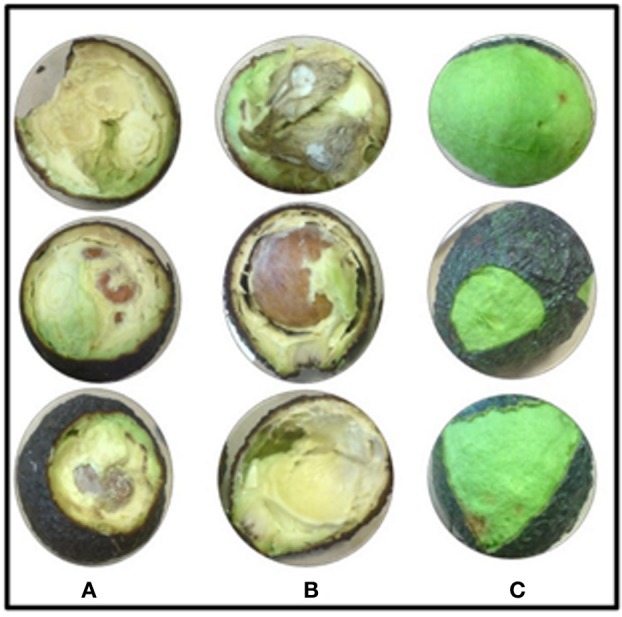
Avocado fruit maturity at the intermediate state, within 7 days of treatment. (A) Control fruits (without chitosan, not-inoculated). (B) Inoculated fruits without chitosan. (C) Inoculated fruits and treated with Chitosan. Symptoms in (A,B) belong to anthracnose, (softening pulp and characteristic mycelium development of C. gloeosporioides), whereas in (C) fruits treated with chitosan, do not present development of C. gloeosporioides.